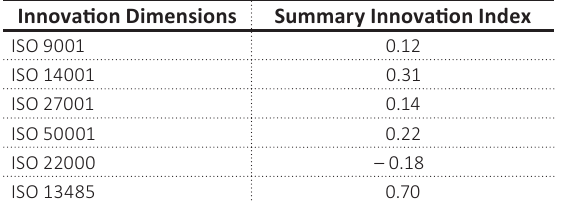
Table 2. Correlation between different types of ISO indicators and SII